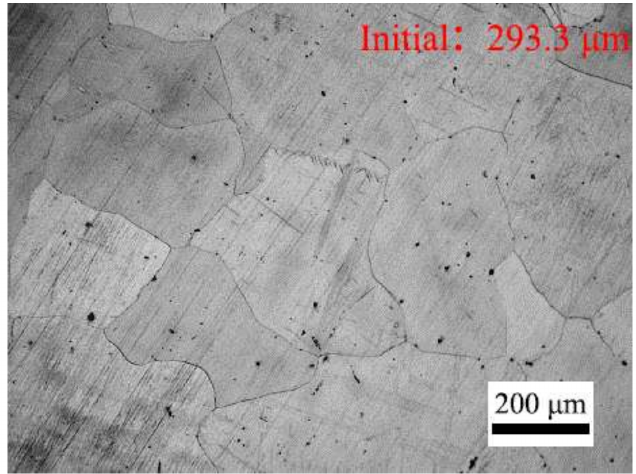
Figure 1. Metallographic observation of the initial material after homogenized annealing.